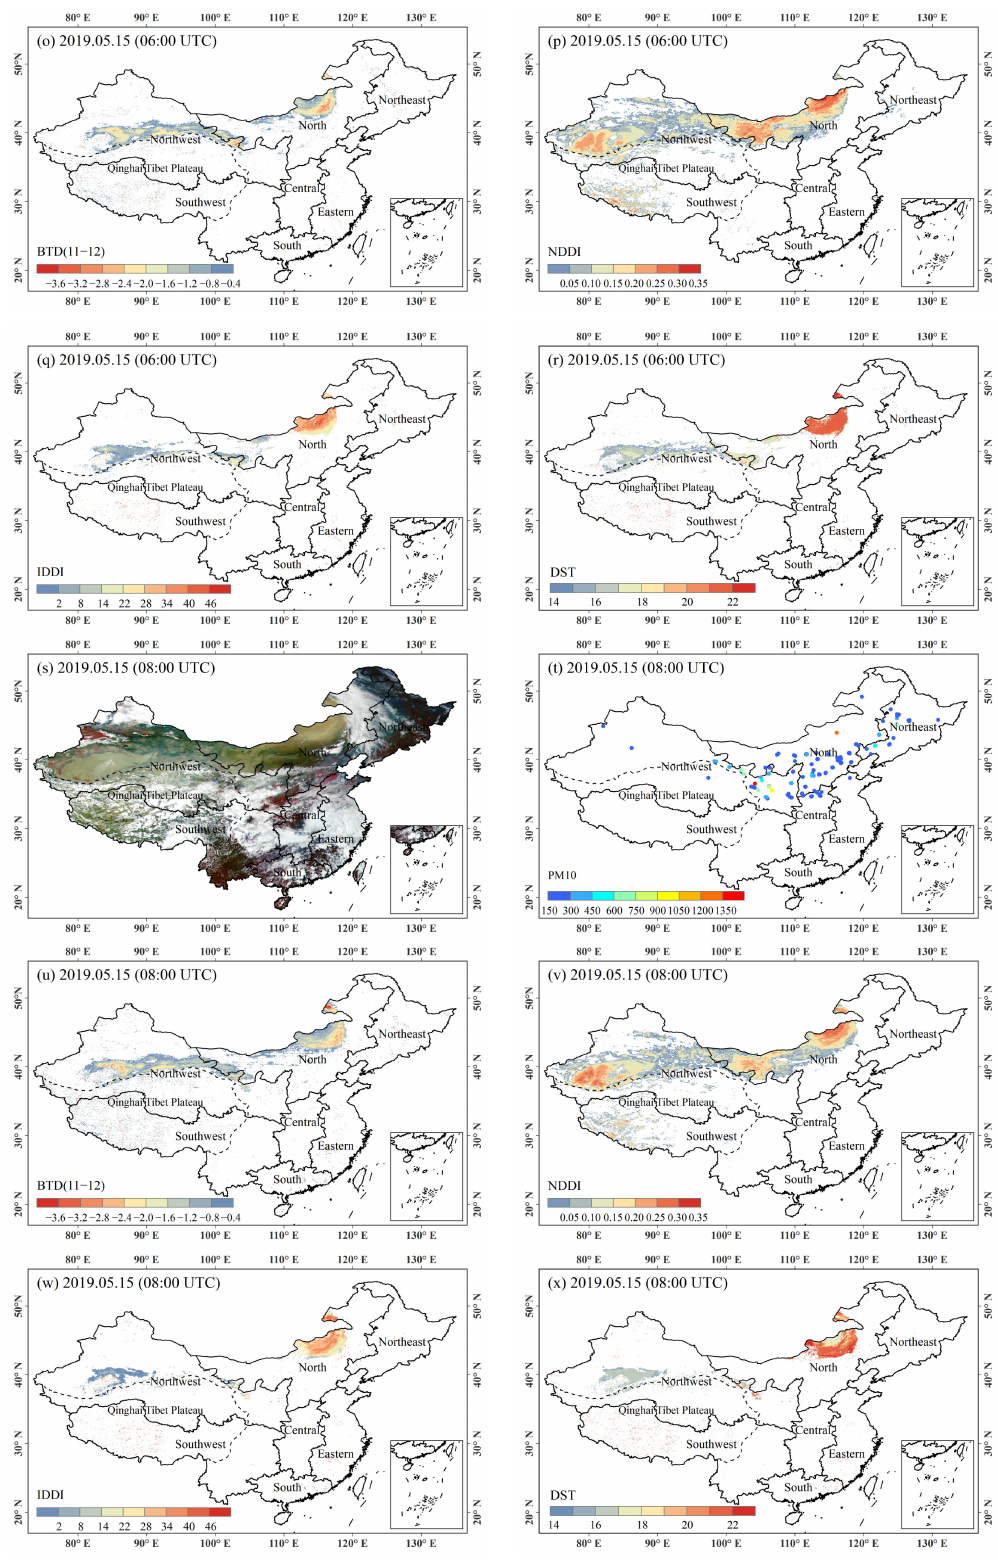
Figure 3 . FY-4A AGRI true color images ( a , g , m , s ), PM10 ( b , h , n , t ), BTD ( c , i , o , u ), NDDI ( d , j , p , v ), IDDI ( e , k , q , w ), and DST ( f , l , r , x ) corresponding to the times of 15 May 2019 from 02:00 to 08:00 UTC, respectively.